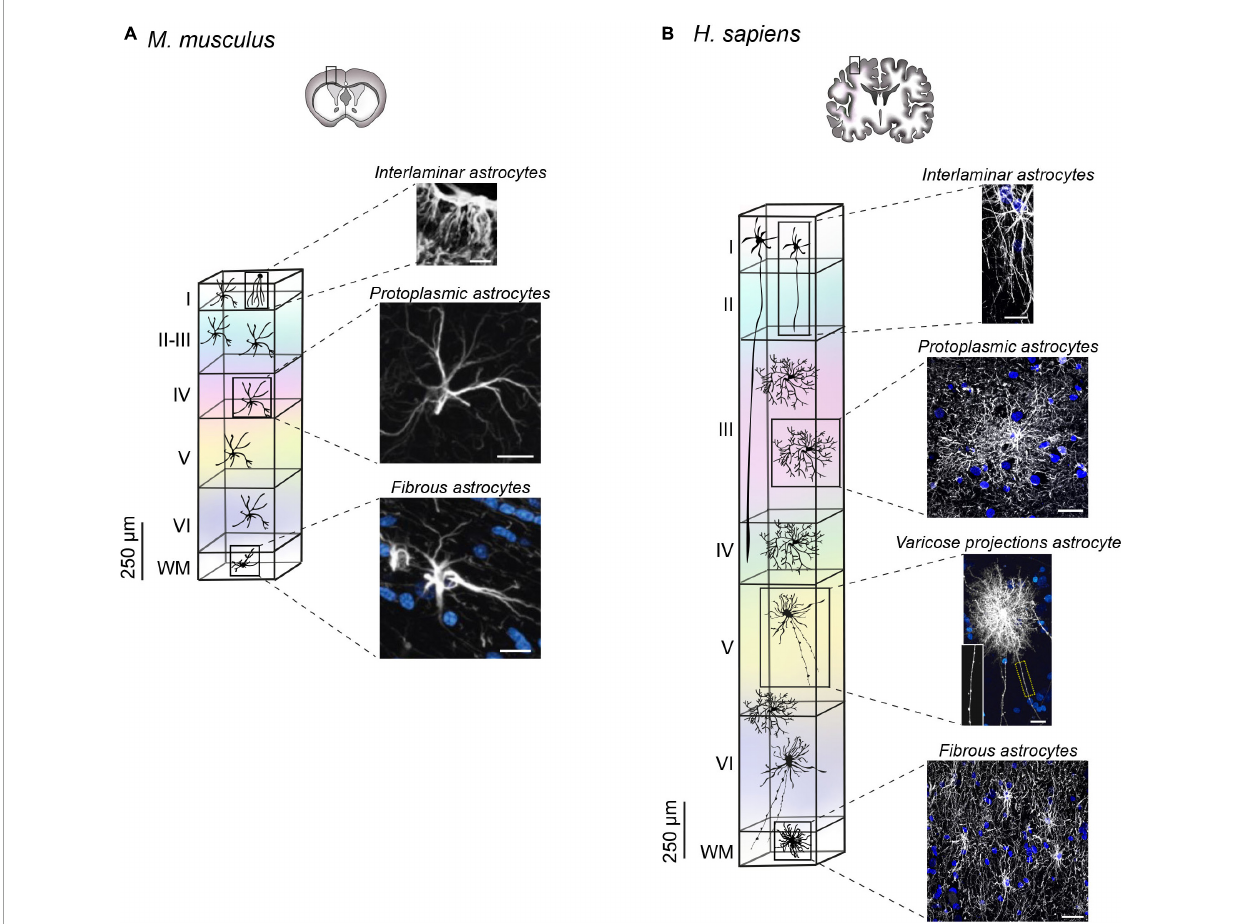
FIGURE2 Arrangement and morphology of human and mouse astrocytes. (A) In mice, three types of astrocytes have been identified: protoplasmic, fibrous and rudimental interlaminar. Interlaminar astrocytes in mouse cortex reside in layer 1 with very short processes identified by immunohistochemical labeling of GFAP [image adapted and modified from Falcone et al. (2019); scale bar 50 µ m]. Protoplasmic astrocytes localize in all layers, whereas fibrous astrocytes are found in WM. Both subtypes are labeled by immunofluorescence staining of GFAP image adapted and modified from Oberheim et al. (2009). Scale bar for protoplasmic astrocyte 20 µ m, scale bar for fibrous astrocyte 10 µ m. (B) Human astrocyte spatial arrangement in the cortex depends on the cellular subtype. The soma of interlaminar astrocytes localizes in layer 1 with projections reaching layers 2–4 (scale bar 15 µ m). Protoplasmic astrocytes reside in layers 2–6 (scale bar 30 µ m), whereas varicose projection astrocytes are found in layers 5–6 and in WM (scale bar 20 µ m). Fibrous astrocytes localize in the WM (scale bar 30 µ m). Astrocyte images are adapted from Degl’Innocenti et al. (2022) (immunofluorescence staining of GFAP) with the exception of varicose projection astrocyte image adapted and modified from Oberheim et al. (2009), generated by diolistic labeling. All images were readapted with permission (Copyright 2009 Society for